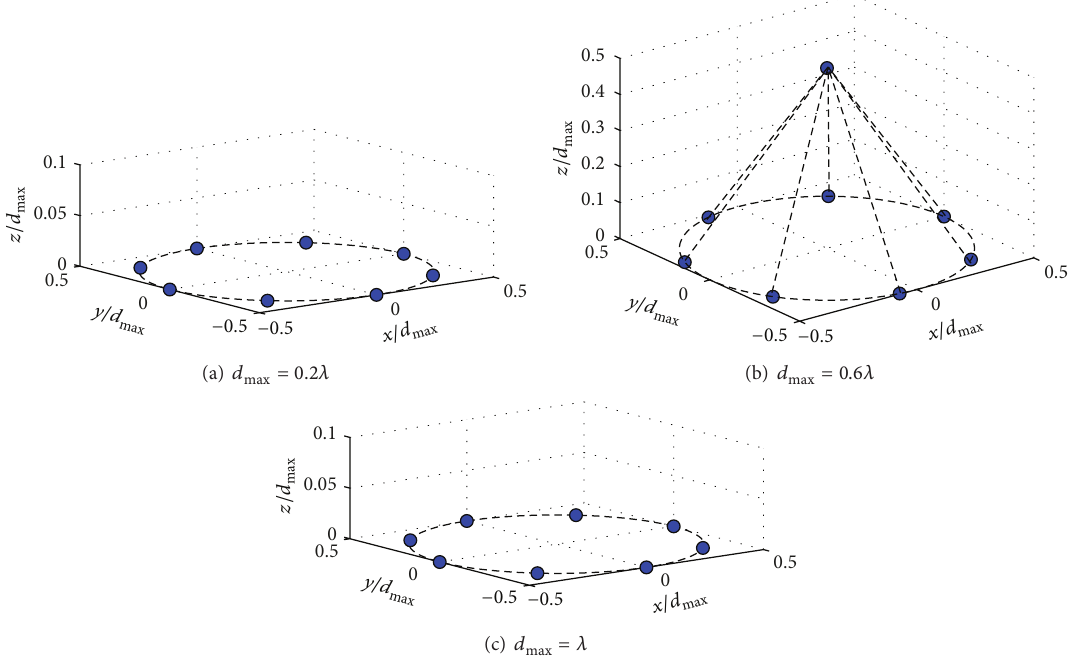
Figure 5: The optimal layout for Scenario II.